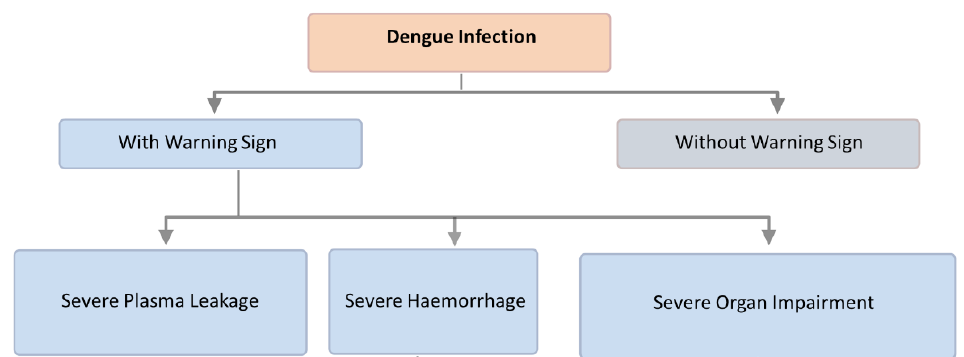
Figure 2. Classification of dengue disease: Dengue can range from an infection with no symptoms to a serious condition, as shown in the flowchart of Figure 2 (Note: classification based on WHO dengue guidelines—2009).